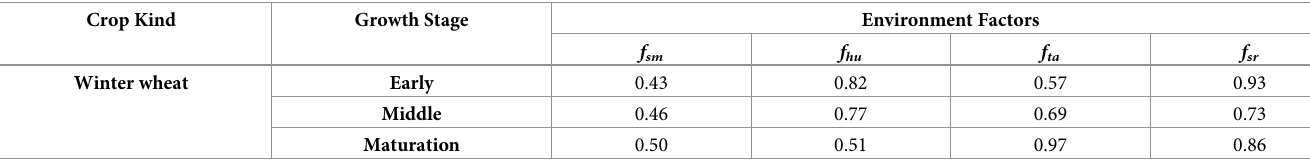
Table 6. Environmental factor values for winter wheat during different